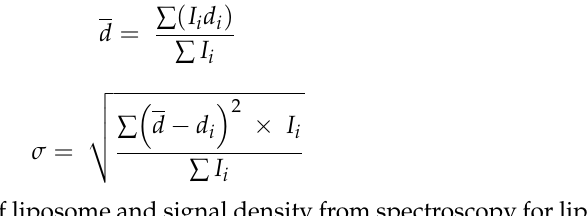
Figure 12. Flow and mixing visualization in micro-channel device.